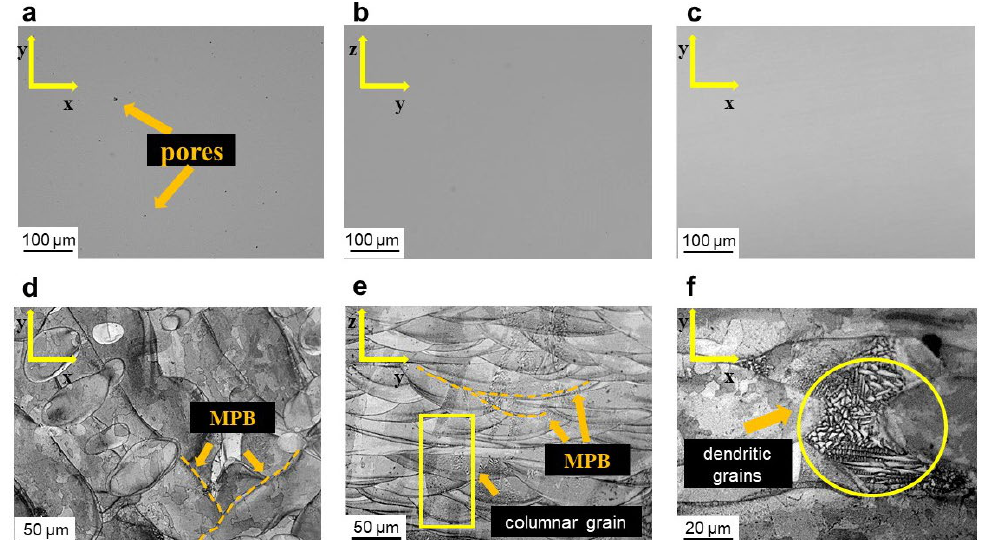
Figure 2. OM images of as-built Hastelloy X (HX) sample: ( a ) pores in the samples before parameter optimization (as marked by yellow arrows); ( b,c ) near fully dense after parameter optimization along the y-z and x-y planes; ( d,e ) the melt pool boundaries (MPB) along the x-y and z-y planes; ( f ) cellular and columnar shapes of dendritic with molten pools.